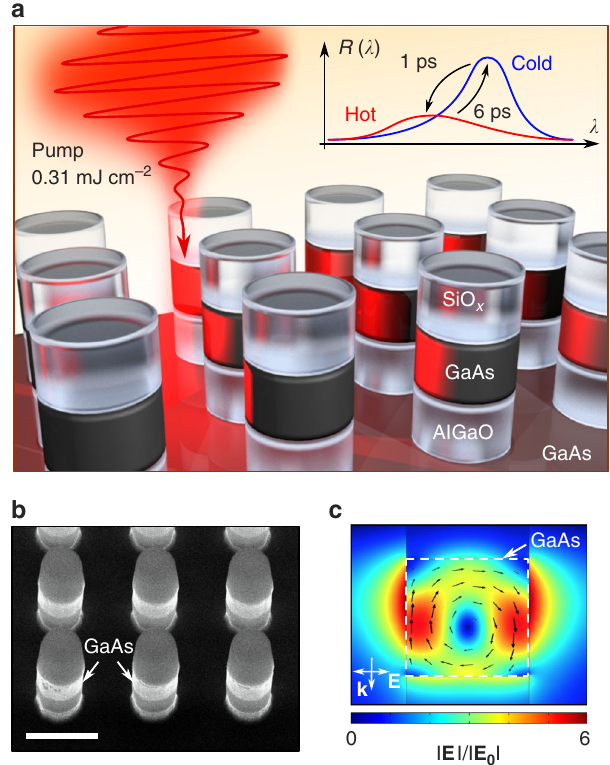
Fig. 1 Tuning GaAs metasurfaces with femtosecond laser pulses. a Illustration of ultrafast tuning of the MD mode at low pump fl uences. The resonance position is tuned within a 6-ps time window due to free carrier injection and subsequent recombination. b Scanning electron micrograph of a metasurface sample. The scale bar is 500 nm. c Electric fi elds of the MD mode in the vertical cross-section of a nanodisks, as excited by the probe